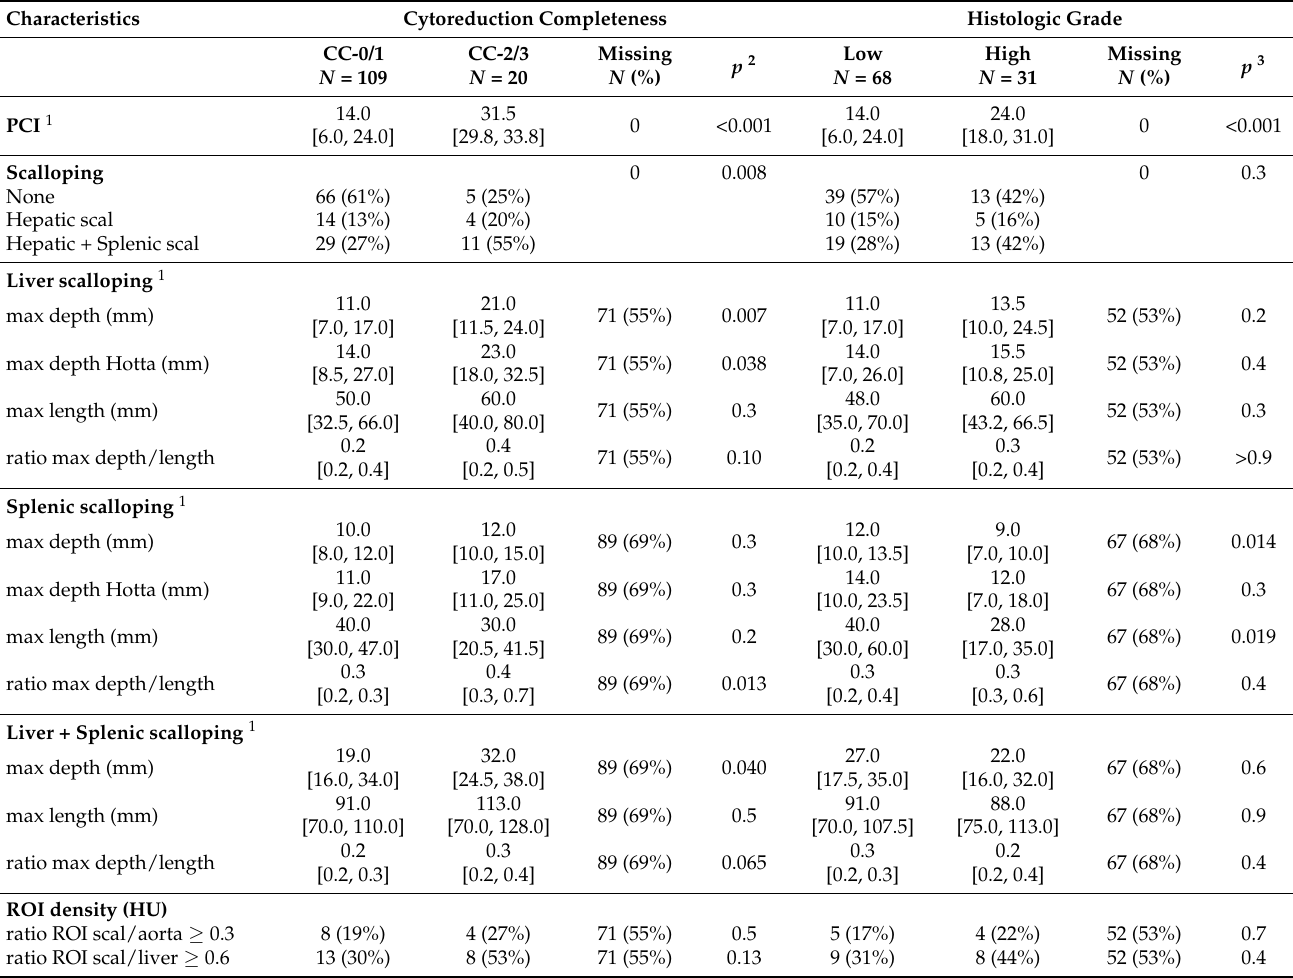
Table 3. Scalloping parameters by resectability and histologic